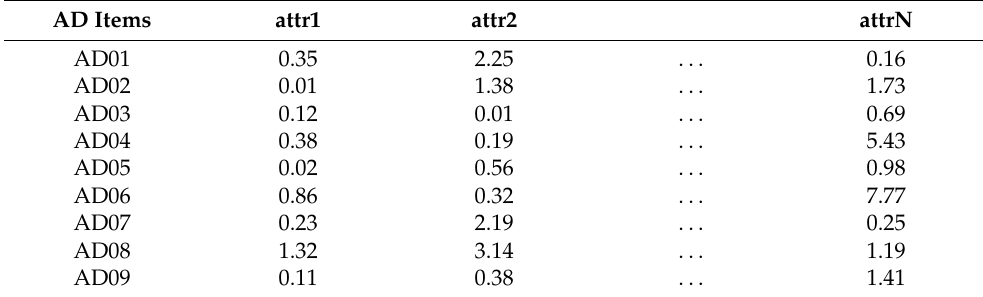
Table 14. Regression coefficients of the influence of various attributes on advertising preference